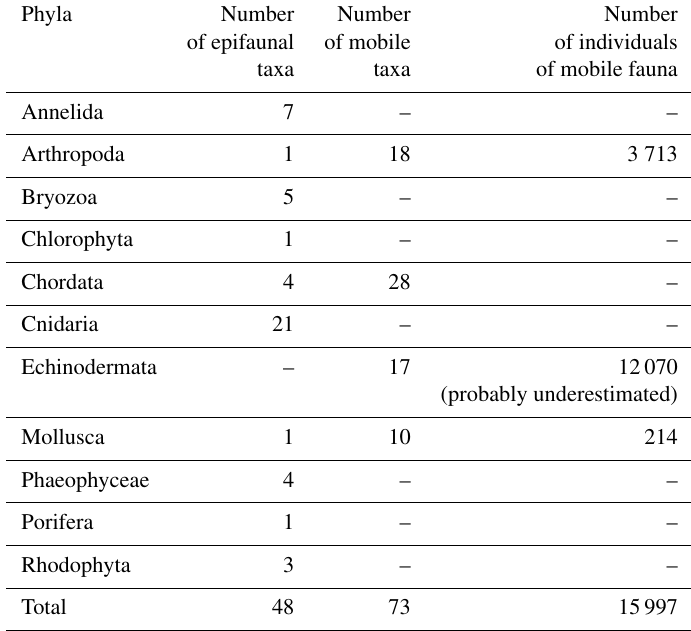
Table 1. Phyletic composition of fauna and flora identified during visual inspection. Phyla Number Number Number of epifaunal of mobile of individuals taxa